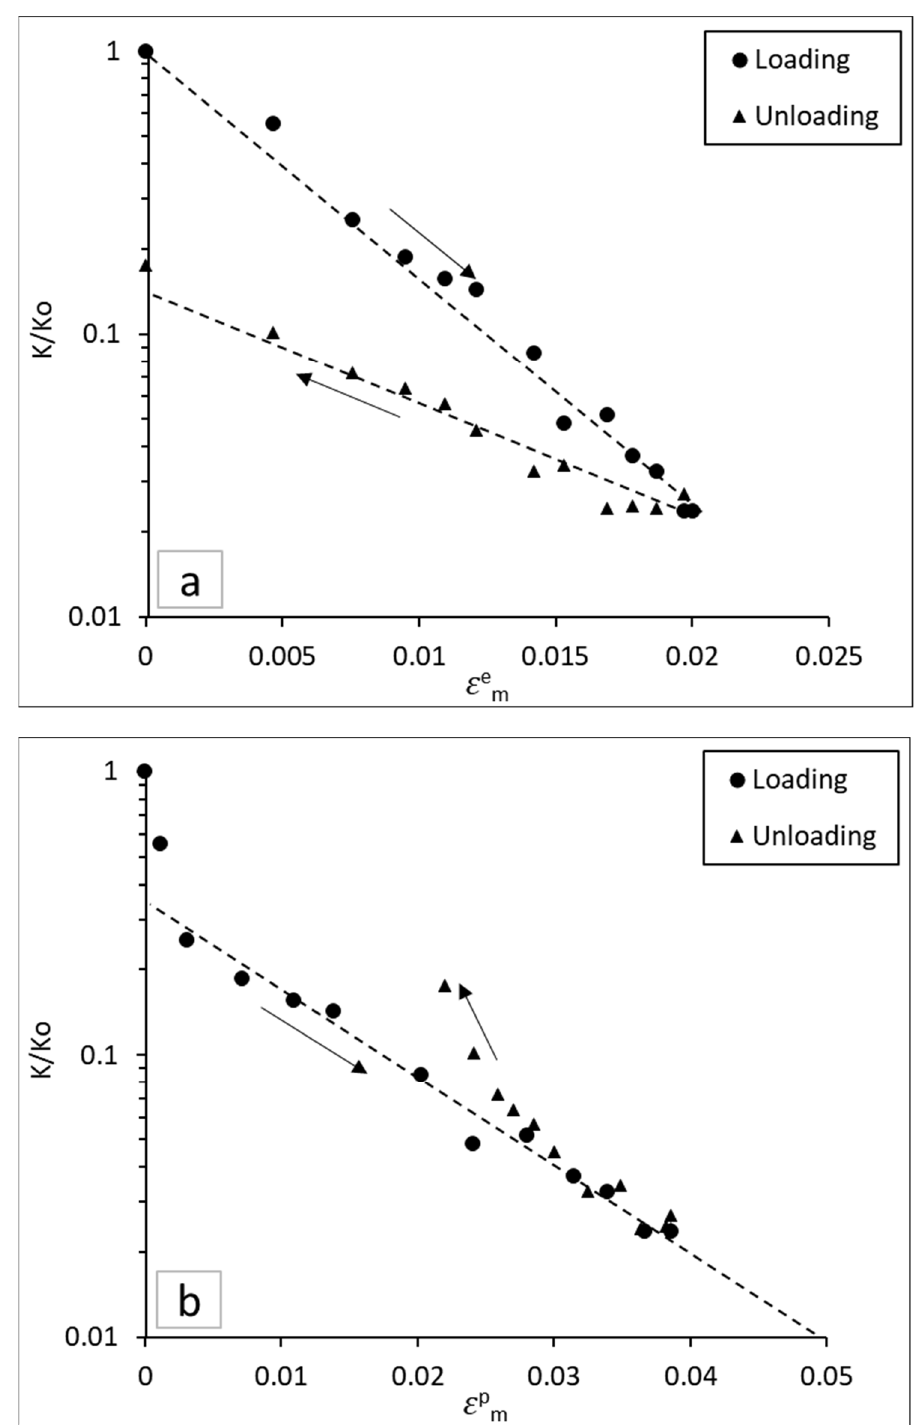
Figure 23. Permeability and elastic/plastic strain of coal sample 3 (test 3).